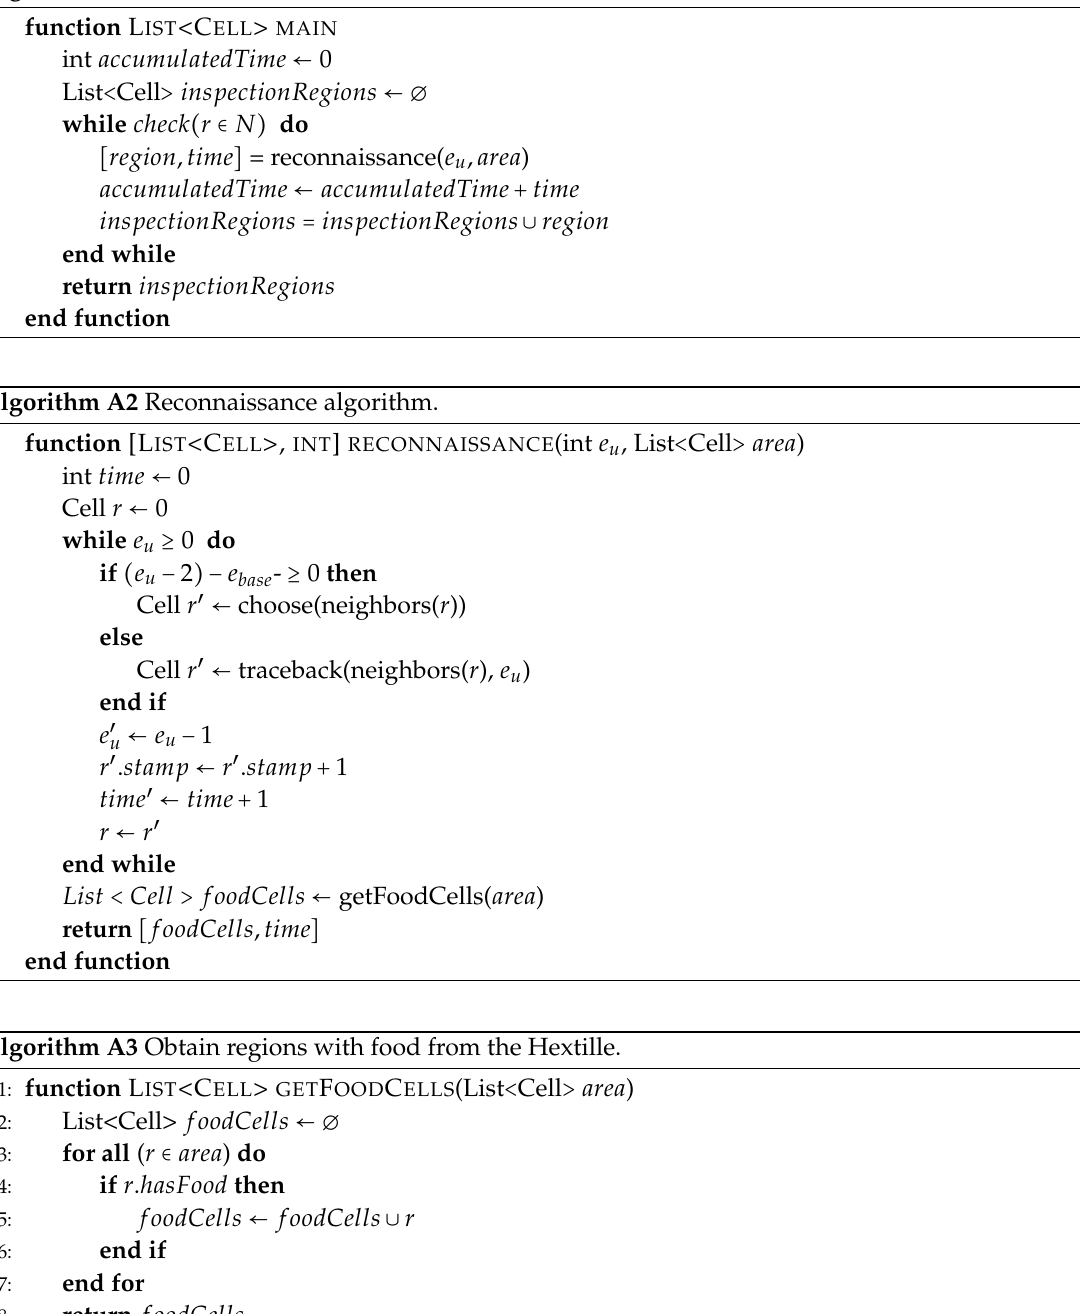
Algorithm A1 Main function.